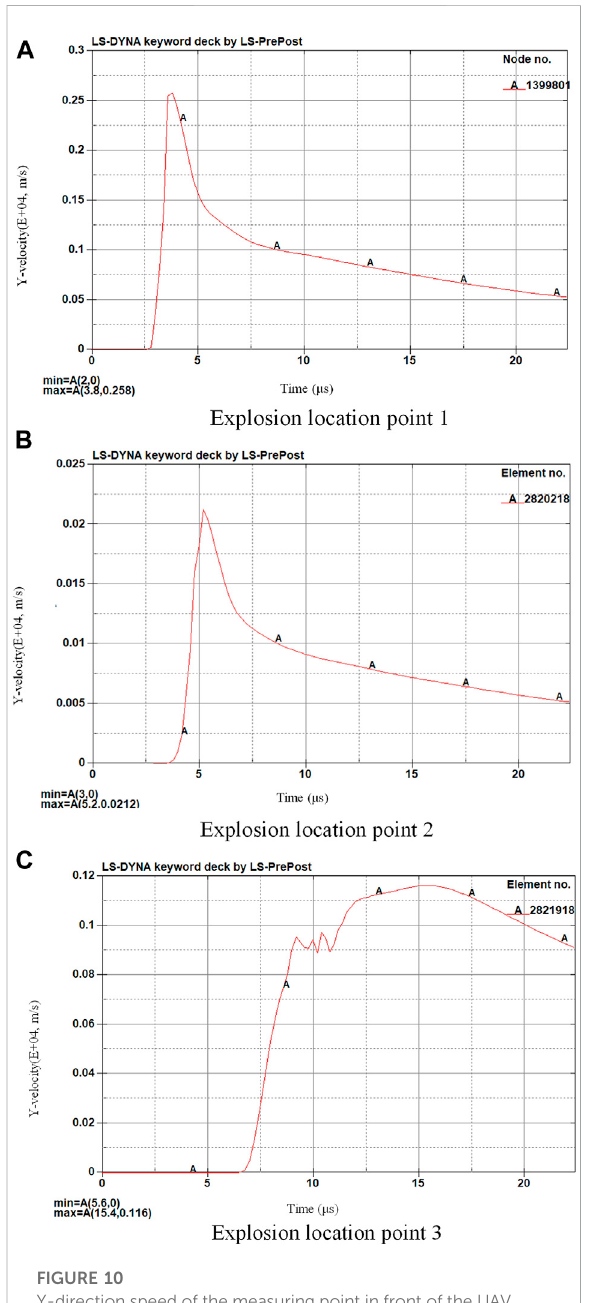
FIGURE 11 Z-direction velocity of the measuring point in front of